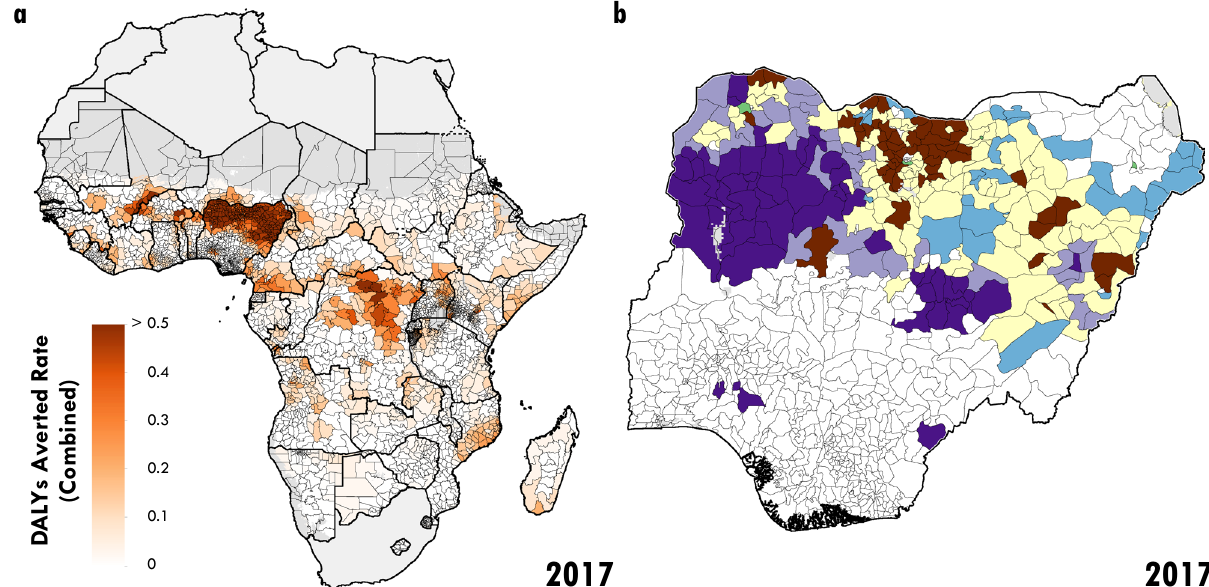
Fig.3|Counterfactualanalysisin2017.a Second administrativelevel reductions in combined DALY rates b Map of second administrative units in Nigeria whose averted combined DALYs exceeded 10,000, the primary component of the local compositionofburdenisplotted.Unitswhere the combinedDALYs averted were less than 10,000 are plotted as white. Units with dark purple have greater than 60% of their averted combined burden attributable to malaria. Units coloured